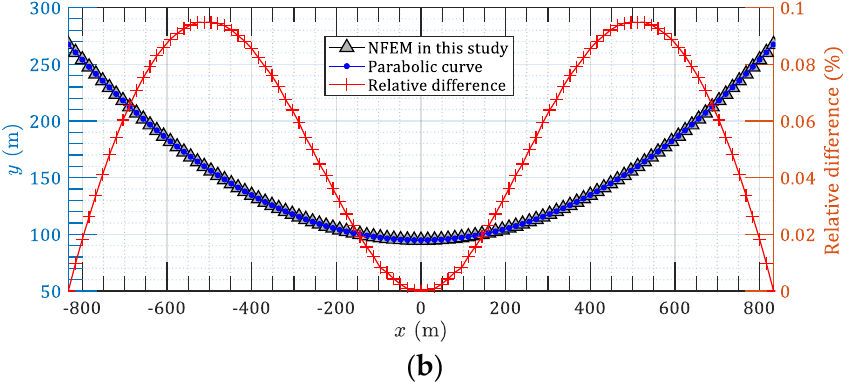
Figure 8. Comparison of the cable shape for 2D parallel main cable: ( a ) NFEM vs. SCM; ( b ) NFEM vs. Parabolic theory.